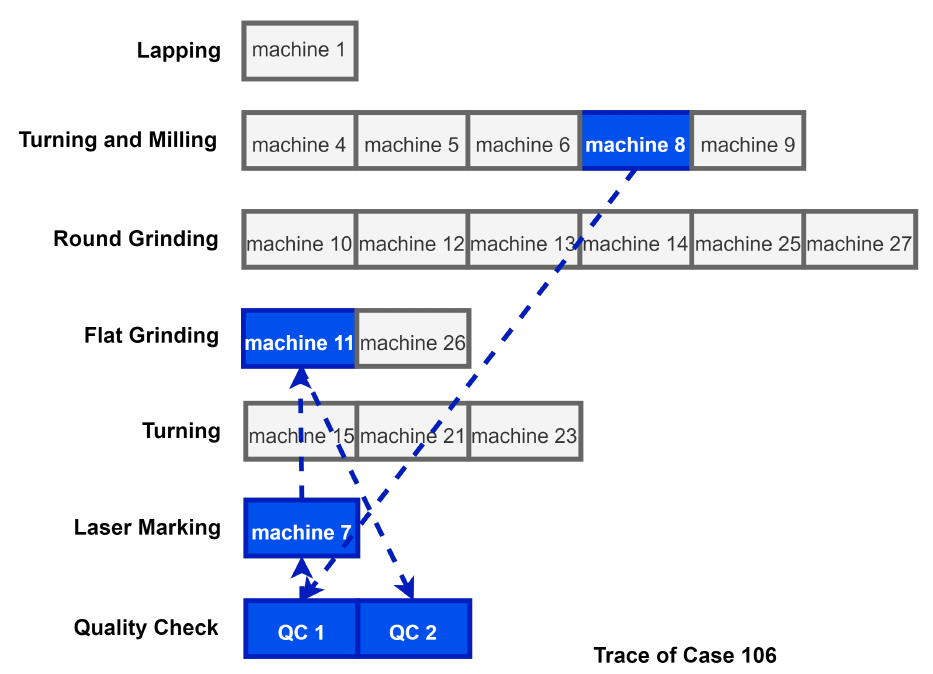
Figure 10. Manufacturing process